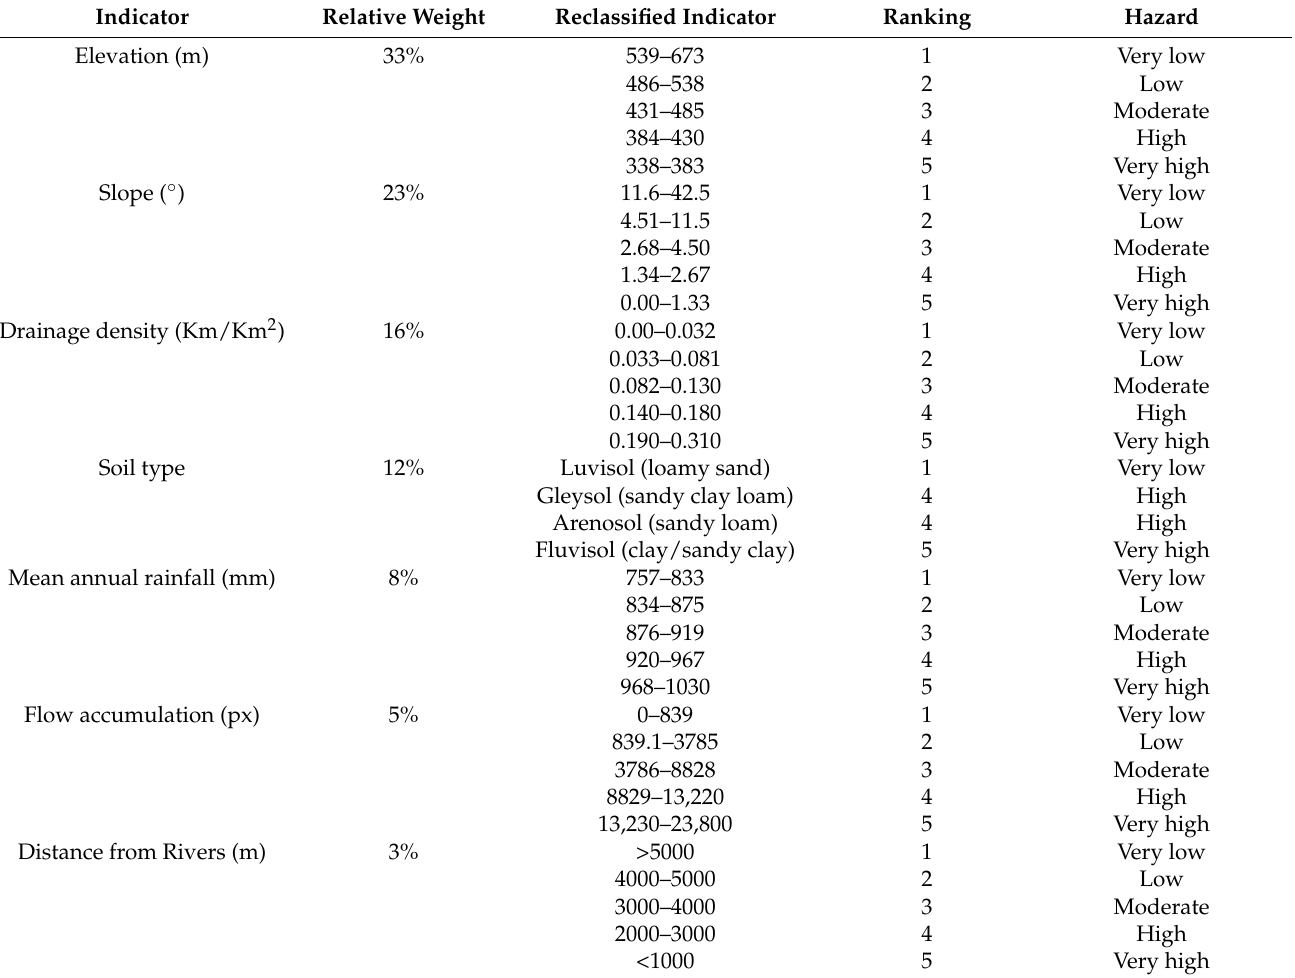
Table 5. Classes of flood hazard indicators, and their weight and